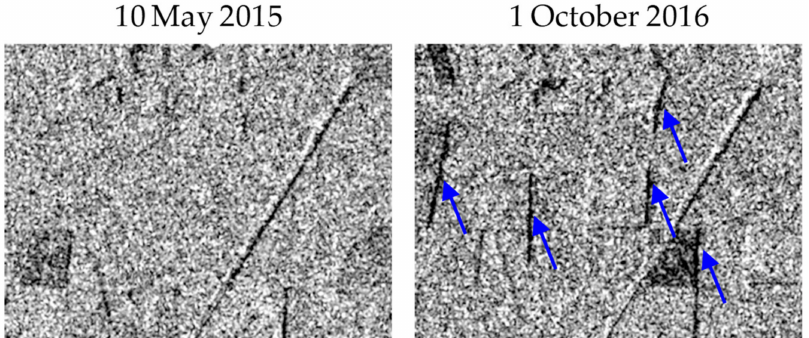
Figure 6. A 2.6 km × 3.4 km subset of Sentinel-1 intensity images acquired in descending orbit on 10 May 2015 and 1 October 2016 over a rubber plantation area, centered on 11 ◦ 16 (cid:48) 40”N 106 ◦ 39 (cid:48) 40”E. Blue arrows indicate shadows that appear between the two dates because of